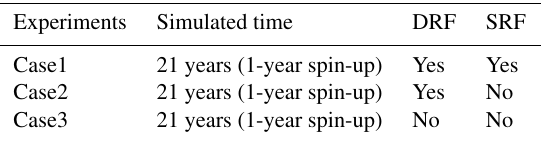
Table 1. Description of the model experiments in this work. Here DRF represents dust direct radiative forcing and SRF is defined as dust-in-snow radiative